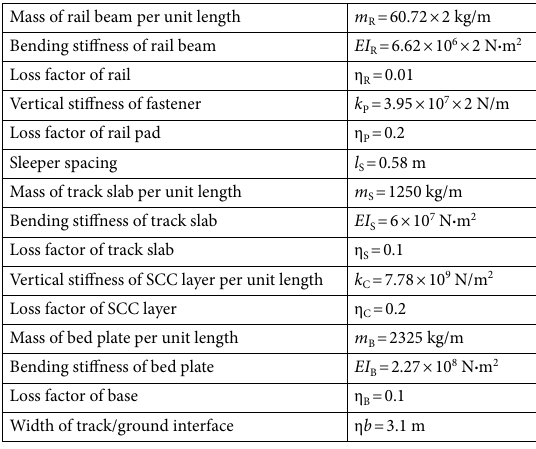
Mass of rail beam per unit length